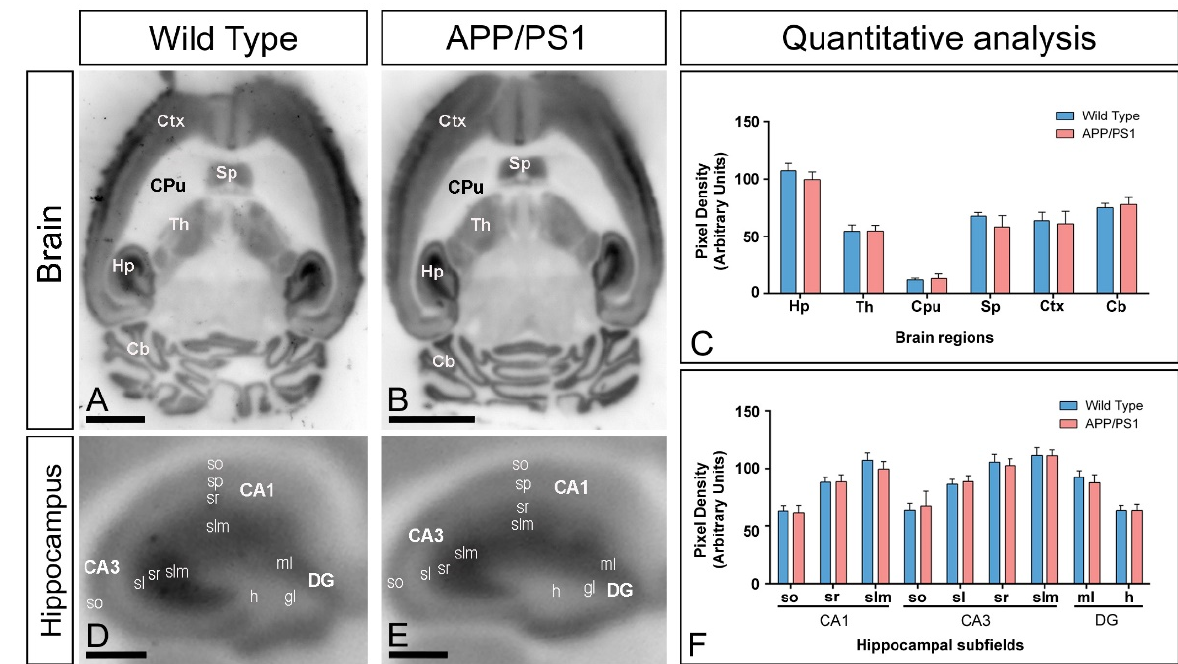
Figure 3. Regional expression of GIRK2 in the brain of APP/PS1 mice. ( A – C ) The regional brain expression was visualised in histoblots of horizontal brain sections at 12 months of age in wild type and APP/PS1 mice using an affinity ‐ purified anti ‐ GIRK2 antibody. The expression of GIRK2 revealed marked region ‐ specific differences, with strongest immunoreactivity in the hippocampus (Hp), neocortex (Ctx), cerebellum (Cb), septum (Sp), and thalamus (Th) and weakest in the caudate putamen (CPu). Densitometric analysis showed no differences in GIRK2 expression in APP/PS1 mice compared to age ‐ matched wild type controls. Error bars indicate SEM. ( D – F ) Hippocampal expression of GIRK2 in wild type and APP/PS1 mice visualised in histoblots of horizontal sections at 12 months of age. Expression for GIRK2 was strong in all dendritic layers of the CA1 and CA3 region and DG, with the strata lacunosum–moleculare (slm) and radiatum (sr) of the CA1 and CA3 regions and molecular layer (mL) of the DG showing the highest expression levels. A moderate expression was observed in the stratum oriens (so) of CA1 and CA3, and the stratum lucidum (sl) of CA3. The hilus (h) of the DG showed the lowest GIRK2 expression level in this region. Densitometric analysis showed no differences in GIRK2 expression in the hippocampal dendritic layers of APP/PS1 mice compared to age ‐ matched wild type controls. Error bars indicate SEM. Abbreviations : CA1 region of the hippocampus; CA3, CA3 region of the hippocampus; DG, dentate gyrus; so, stratum oriens ; sp, stratum pyramidale ; sr, stratum radiatum ; slm, stratum lacunosum ‐ moleculare ; ml, molecular layer; gl, granule cell layer; h, hilus. Scale bars: ( A , B ): 0.2 cm; ( D , E ): 0.05 cm.